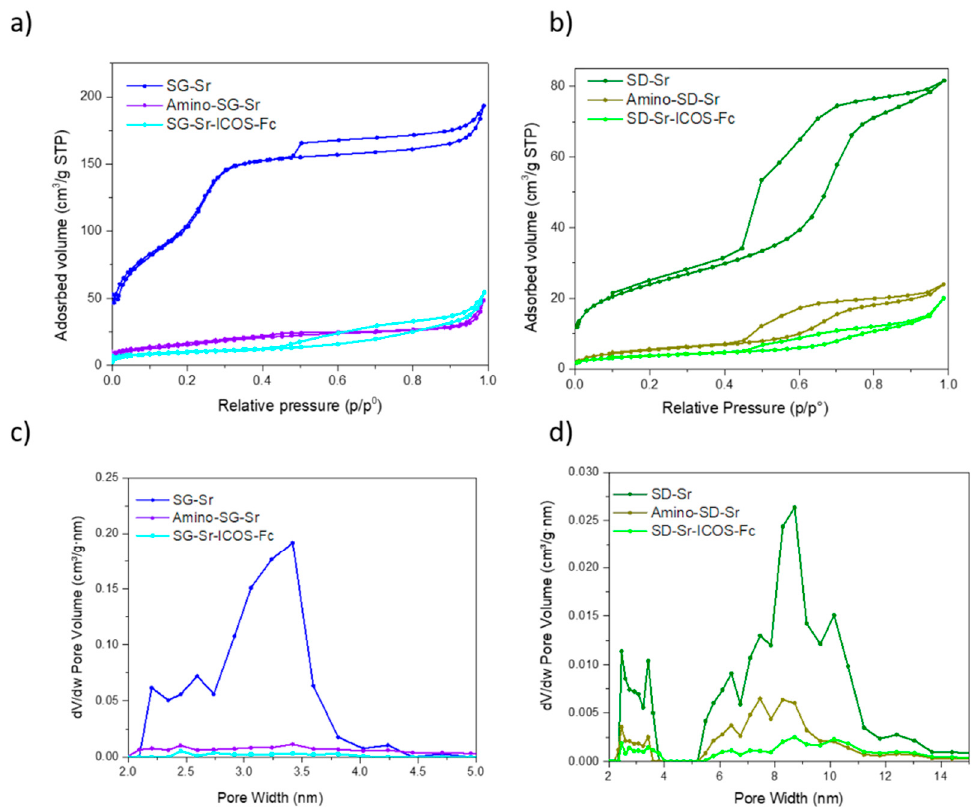
Figure 4. N 2 adsorption-desorption isotherm of SG-Sr, Amino-SG_Sr and SG-Sr-ICOS-Fc ( a ), SD-Sr, Amino-SD_Sr and SD-Sr-ICOS-Fc ( b ). Pore size distribution of SG-Sr, Amino-SG_Sr and SG-Sr-ICOS-Fc ( c ), SD-Sr, Amino-SD_Sr, and SD-Sr-ICOS-Fc ( d ). Table 1. SSA BET and total pore volume of SG-Sr, SD-Sr, SG-Sr-ICOS-Fc, and SD-Sr-ICOS-Fc.